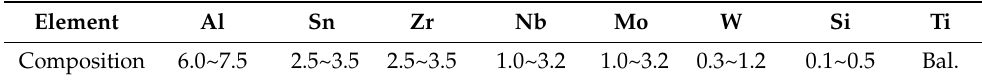
Figure 1. Three-dimensional model of the component. Table 1. The composition of high-temperature TC31 titanium alloy (wt%).